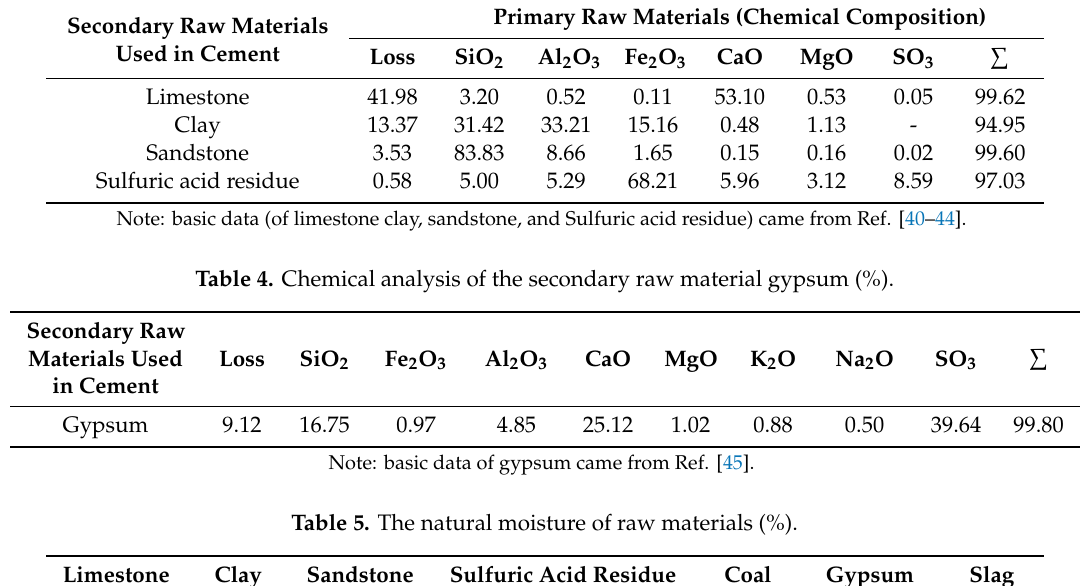
Table 3. Chemical composition of the secondary raw materials: limestone, clay, sandstone, sulfuric acid residue, and coal (%).